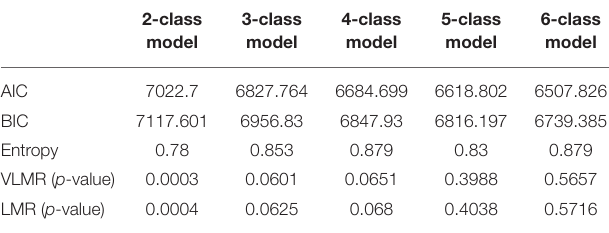
TABLE 2 | Fit indices for the estimated latent class models ( n =